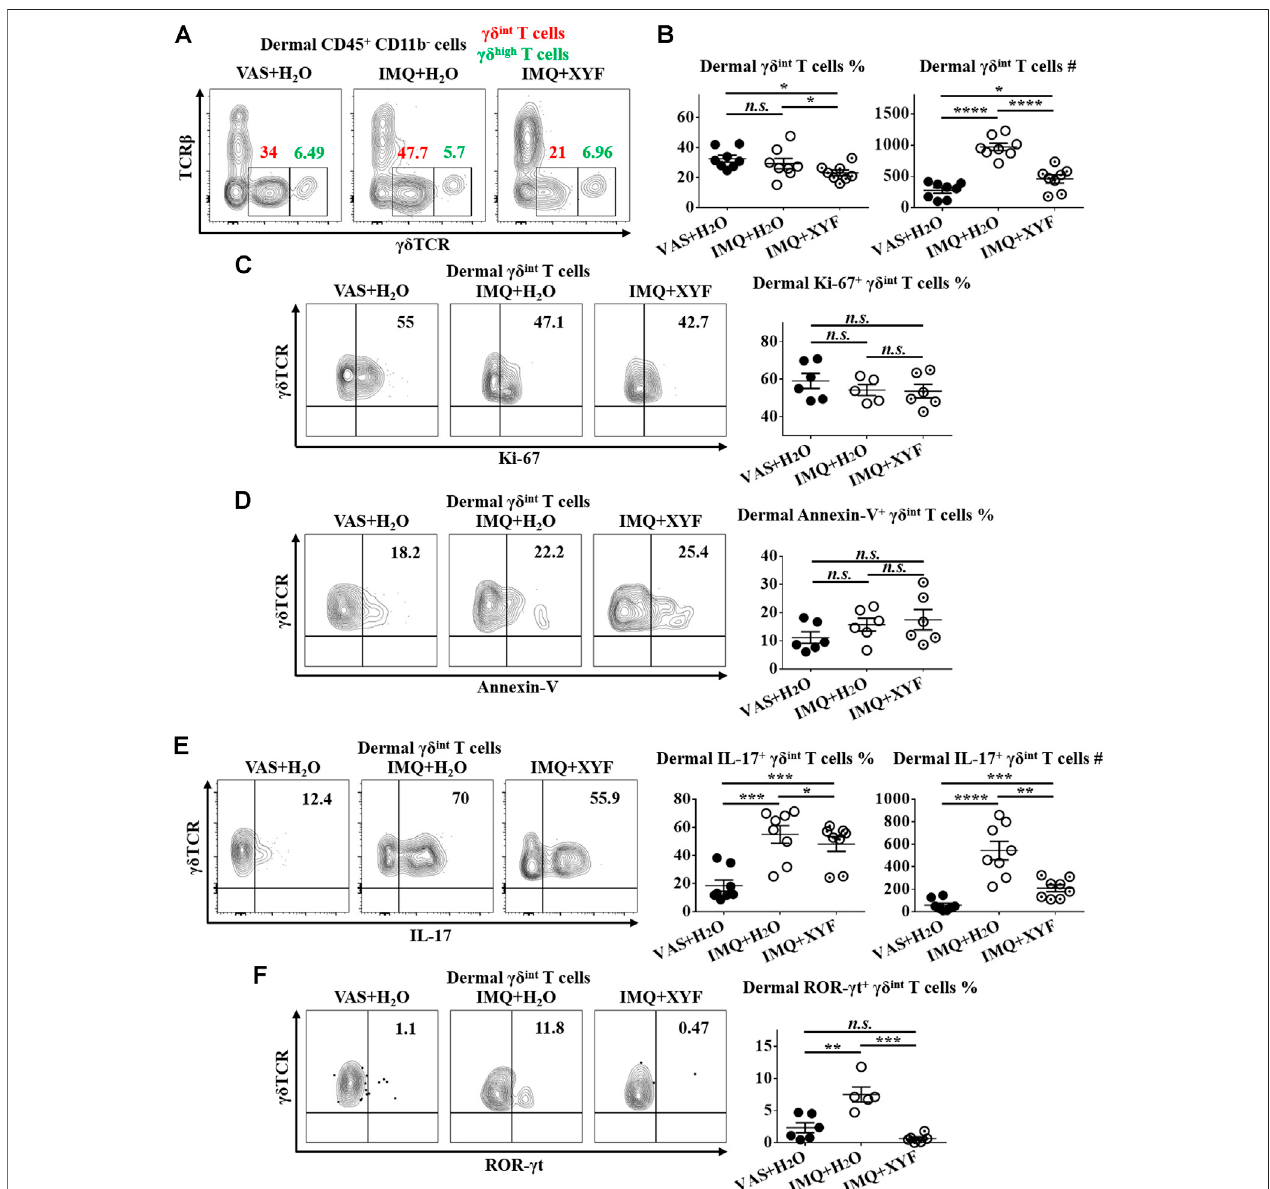
FIGURE5| Xiao-Yin-Fangsuppresseddermal γ δ T17cellpolarization.Miceweretreatedasin Figure4 ,andthedermalcellsofmouseearswereharvested. (A – C) Freshly isolated dermal cells were in vitro cultured in the presence of PMA, ionomycin and Brefeldin A for 4 h. Cultured dermal cells were stained with anti-CD45, TCR β , γ δ TCR, and CD11b antibodies ( n (cid:2) 24, four independent experiments) (A) Representative scatter plots of dermal γ δ int T cells and γ δ high T cells. (B) The ratios and numbersofdermal γ δ int Tcells. (C) Uncultureddermalcellswerestainedwithanti-CD45,TCR β , γ δ TCR,CD11bandKi-67antibodies.Representativescatterplots andtheratiosofdermalKi-67 + γ δ int Tcells( n (cid:2) 17,threeindependentexperiments). (D) Uncultureddermalcellswerestainedwithanti-CD45,TCR β , γ δ TCR,CD11band Annexin-V antibodies. Representative scatter plots and the ratios of dermal Annexin-V + γ δ int T cells ( n (cid:2) 18, three independent experiments). (F) Cultured dermal cells were stained with anti-CD45, TCR β , γ δ TCR, CD11b, and IL-17 antibodies. Representative scatter plots, the ratios and numbers of dermal IL-17 + γ δ int T cells ( n (cid:2) 24, three independent experiments). (G) Uncultured dermal cells were stained with anti-CD45, TCR β , γ δ TCR, CD11b, and ROR- γ t antibodies. Representative scatter plots and the ratios of dermal ROR- γ t + γ δ int T cells ( n (cid:2) 17, three independent experiments). The data were presented as mean ± s.e.m.